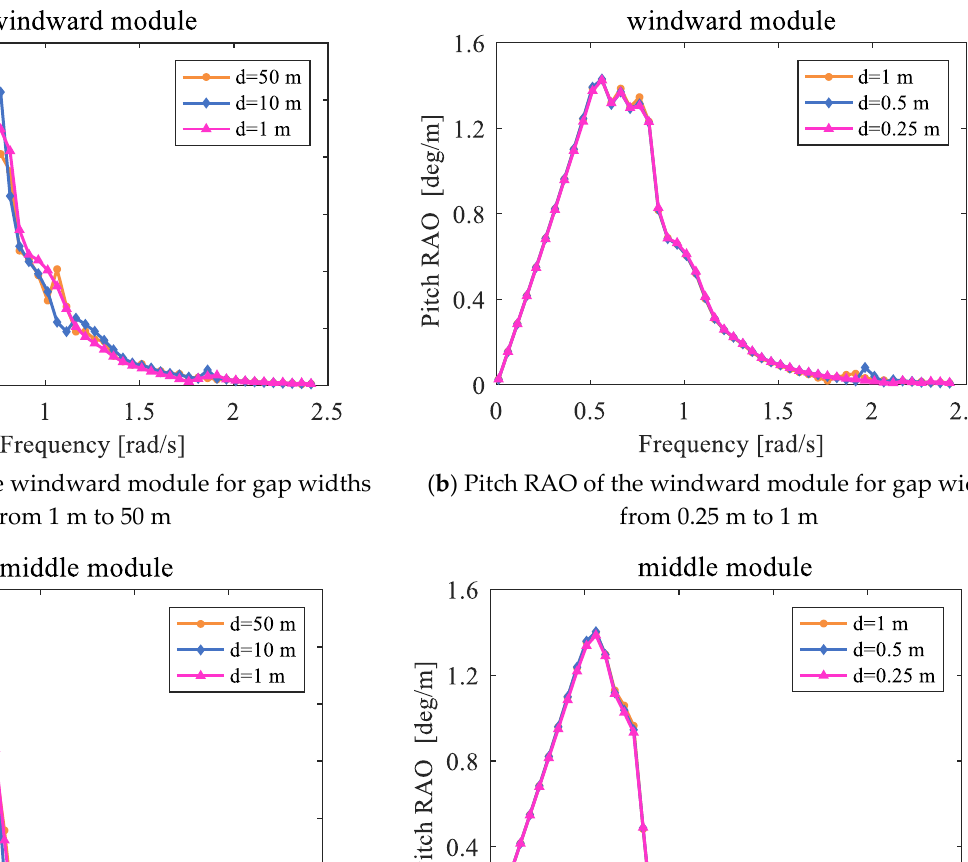
11 of 31 Figure 5. Comparison of the windward module hydrodynamic results with the change of the number of floating bodies (wave angle = 180°).